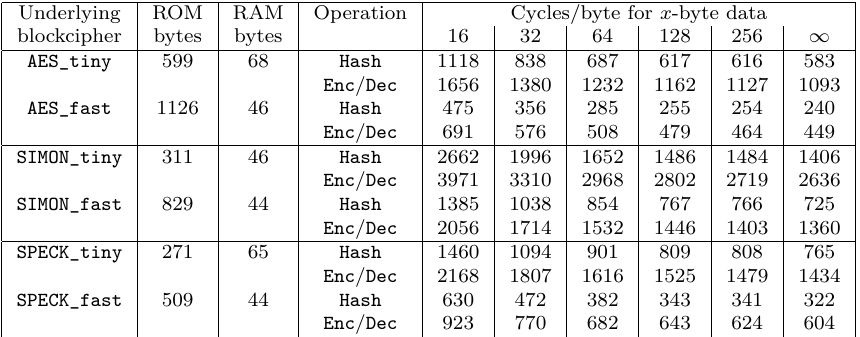
Table 3: Our Implementation of SAEB with the default parameters on